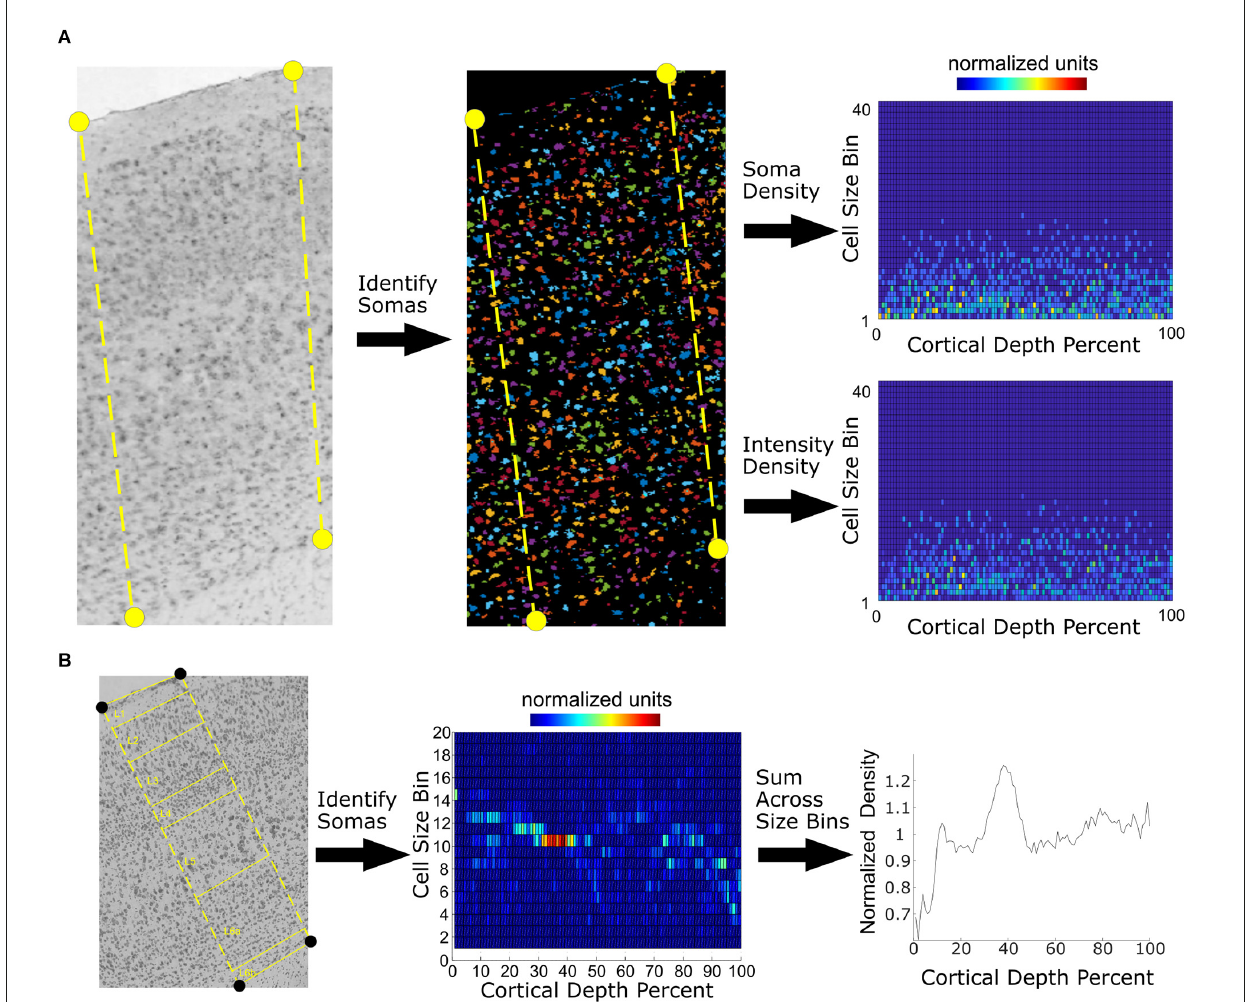
FIGURE1 Counting of cell density and intensity as a function of cortical depth and size. (A) A region of somatosensory cortex, outlined by the yellow dashed lines, from L1 through L6 is manually annotated on in situ hybridization (ISH) slices. As an example, we take the image for 2510039O18Rik. Automatic detection of cell somas is performed on the image, and the background subtracted. Each identified spot is marked by a different color in the second image. Cell soma densities are mapped to 100 bins corresponding to their fractional depth. The top of the cortex corresponds to the first bin. The area of each cell body is also calculated, allowing further parcellation into 40 area-depth bins. The total intensity density as a function of area bin and cortical depth is also obtained. (B) Density obtained from Nissl slices. The densities are mapped to 100 depth bins and 40 size bins. Note that the intensity densities from Nissl slices are not used. By summing across the size bins, a plot of density vs. cortical depth percent is obtained.